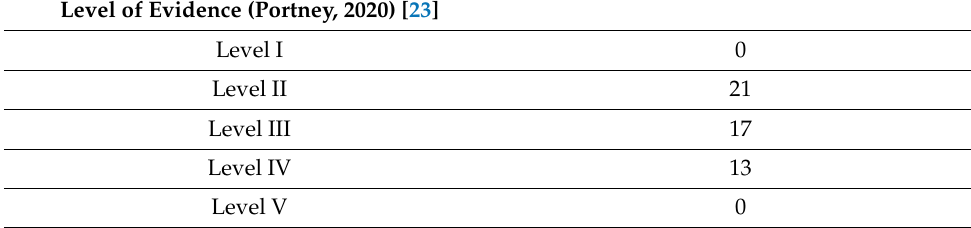
Table 5. Level of